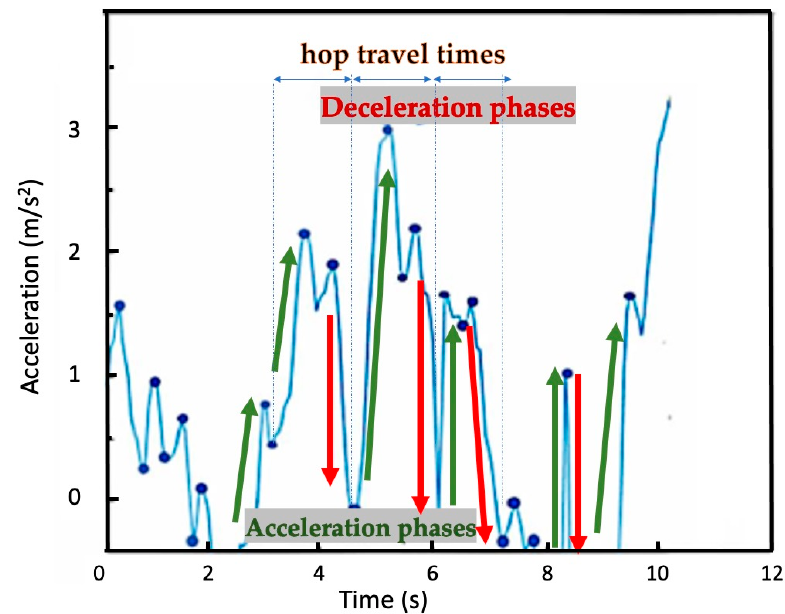
Figure 7. Acceleration time series for one of the trials showing consecutive accelerations (due to hydrodynamic forcing—see portions of the time series adjacent to the green arrows) and decelerating (due to collisions with the bed surface—see portions of the time series adjacent to the red arrows) phases. The results for all of the instrumented particle transport experiments were checked from the top and side cameras to validate transport in saltation mode. As shown in Figure 7, the time between two adjacent maximum and minimum peaks gives the duration of particle acceleration (hop travel time). The hop length can be found as the total distance travelled during that duration. The mean particle velocity can be obtained by calculating the average of the particle’s instantaneous velocity during transport. In the accelerating phase, particle velocity increases under the influence of hydrodynamic forces (function of the instantaneous flow velocity), which will show as an increasing acceleration (e.g., see segments of the time series next to the green arrows in Figure 7). The acceleration will cease suddenly when the particle hits one or more immobile bed surface particles and there will be a loss of some of the particle’s mechanical energy. This impact with the bed surface will be seen as a sudden deceleration, which is observed as a negative peak in the time series of particle’s acceleration (e.g., see segments of the time series next to the red arrows in Figure 7). The total number of hop events and their durations, throughout a particle’s transport, can be found for each experimental run. To assess how the instrumented particle’s saltation processes are changing for differ- ent flow rates and particle densities, several metrics are estimated, including particle hop lengths, particle hop travel durations, mean particle velocity, and the frequency of particle hops (number of particle hops per second). The analysis of experimental results focuses on the statistical distributions of instrumented particle velocities, hop distances, and travel times, derived from sensor data. Stochastic predictive models of particle dynamics are described with these metrics along with their trends for a range of the flow conditions and instrumented particle and bed surface properties.